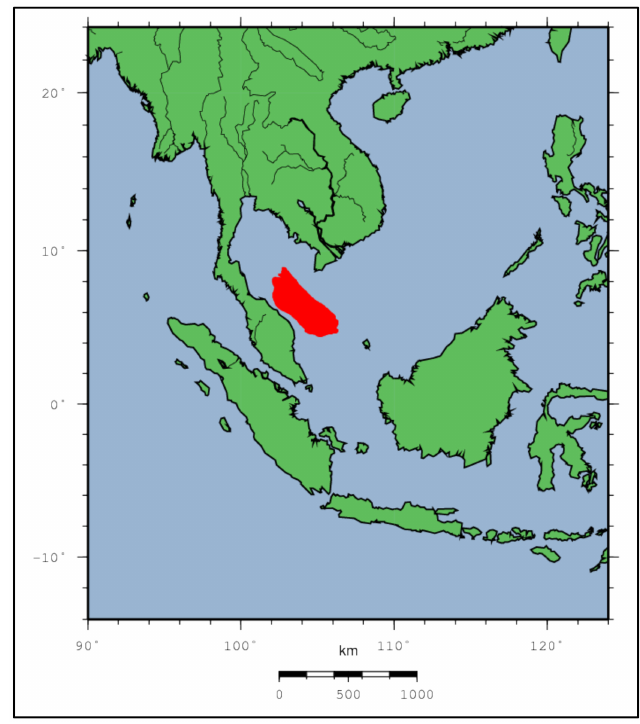
Figure 2. Geographical map of Malay Basin.